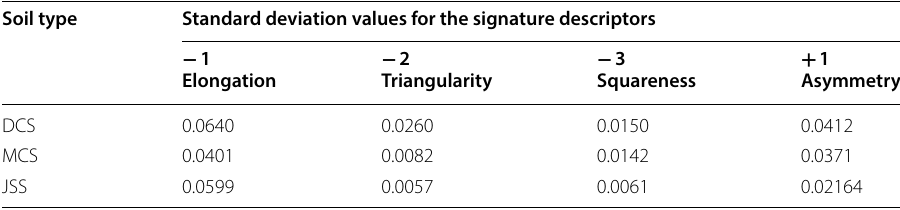
Table 2 General shapes used to investigate Fourier descriptors for morphological characterization, Standard Deviation values for the signature descriptors